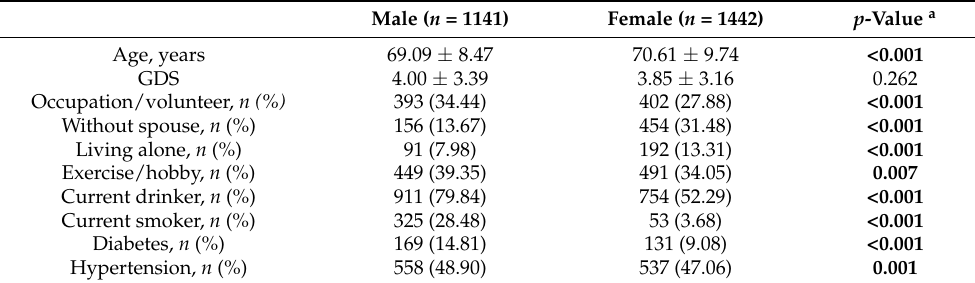
Table 1. Participant